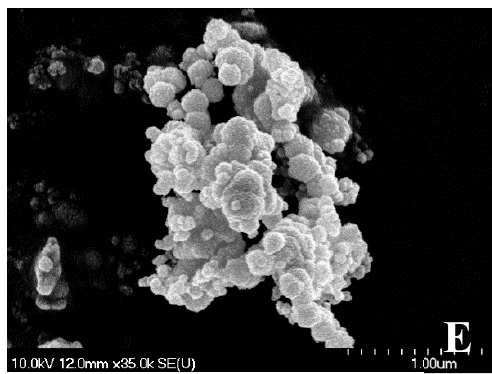
Figure 5. Scanning electron microscopy images of the selected NiNPs ( A : non-stirred, B : mechanically stirred, C : 30 W – 20%, D : 30 W – 100%, E : 120 W – 100% ultrasonically treated samples).